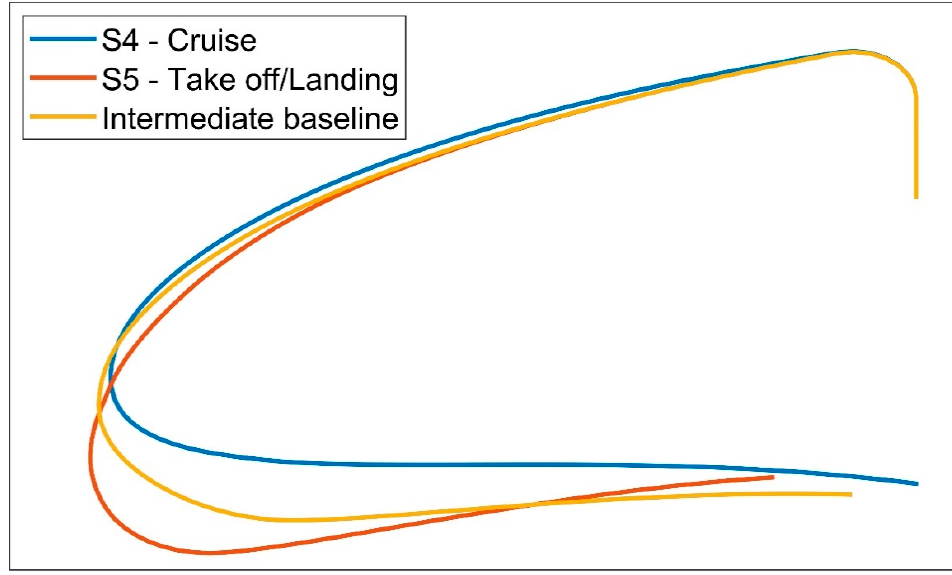
Figure 13. Derived intermediate baseline together with target shapes S4 and